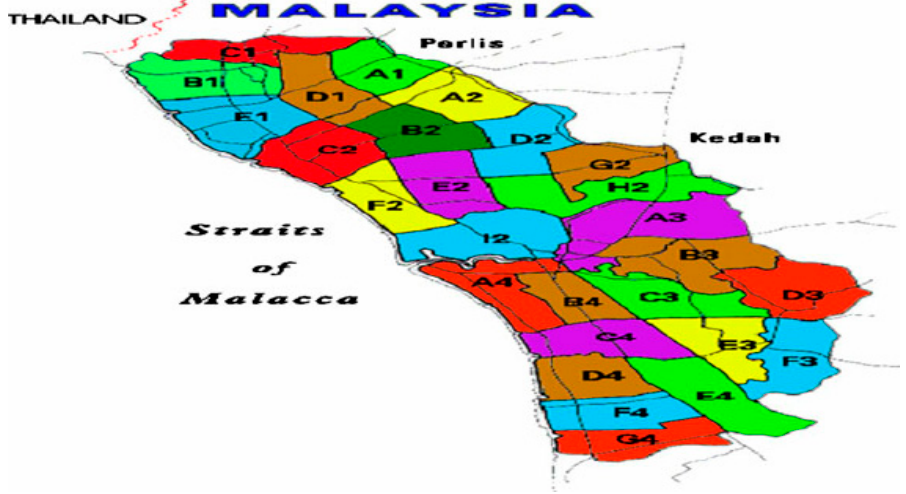
Figure 1. Map of MADA area. Source: Google Maps.